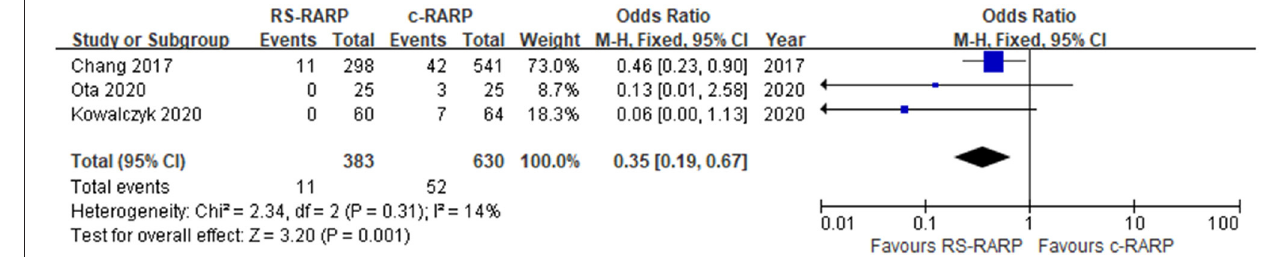
FIGURE 9 | Forest plot of hernia.